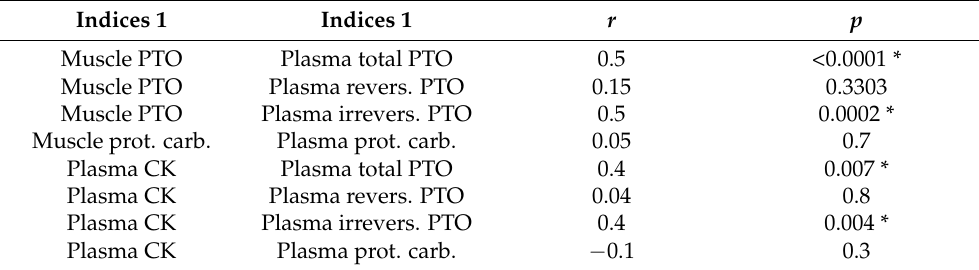
Table 1. Correlation between muscle and plasma protein thiol oxidation (PTO) and protein carbony- lation (prot. carb.) makers, and between plasma CK and plasma protein oxidation markers in C57 and mdx mice. N = 54 and asterisks represent significant correlation of p < 0.05. Indices 1 Muscle